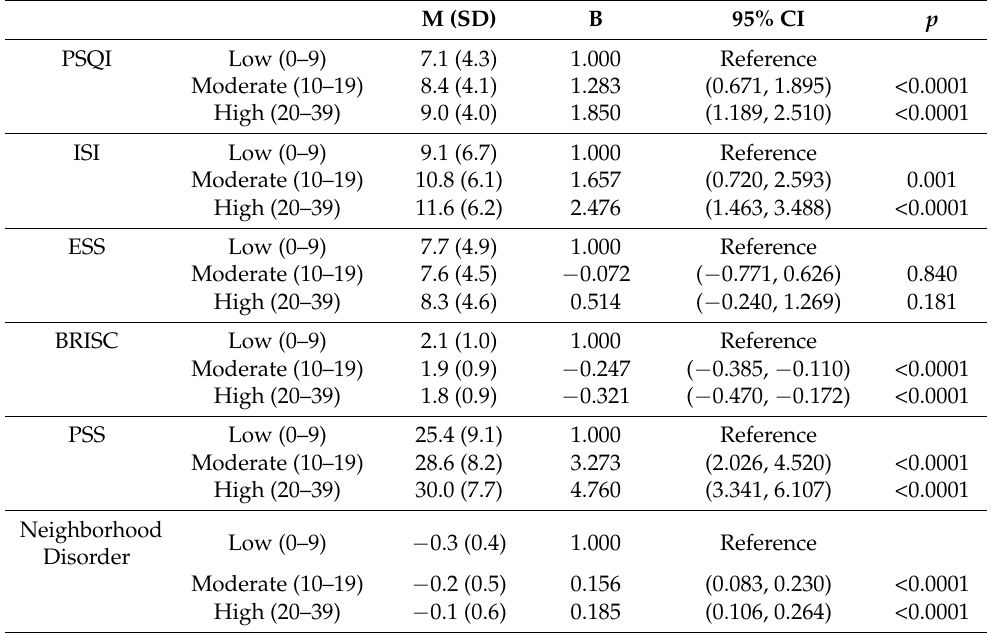
Table 5. ASE Score Categories Associated with Sleep Quality, Insomnia Severity, Daytime Sleepiness, Sleep Control, Perceived Stress, and Neighborhood